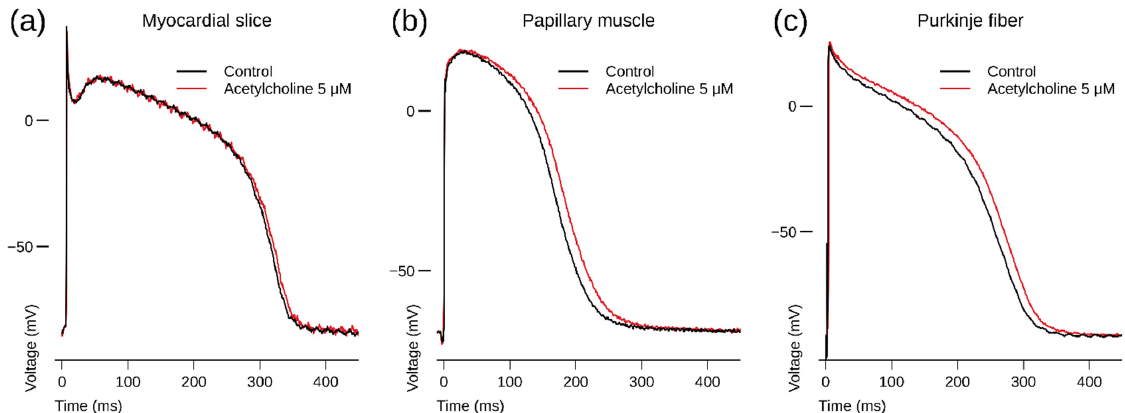
Figure 1. ( a ) Human left ventricular myocardial slice: superimposed recording of action potentials (APs) during control and after 3 min superfusion with ACh (5 µ M) at a BCL of 1000 ms; ( b ) human right ventricular papillary muscle: superimposed recording of APs during control and after 3 min exposure to ACh (5 µ M) at a BCL of 1000 ms; ( c ) human right ventricular Purkinje fiber: superimposed recording of an AP during control and after 3 min exposure to ACh (5 µ M) at a BCL of 500 ms. Note that ACh slightly prolongs repolarization. AP waveform recordings originate from the same preparation and same impalement. Panel a depicts APs recorded from a non-diseased human donor heart; panels b and c depict APs recorded from a human donor heart with 29% ejection fraction.